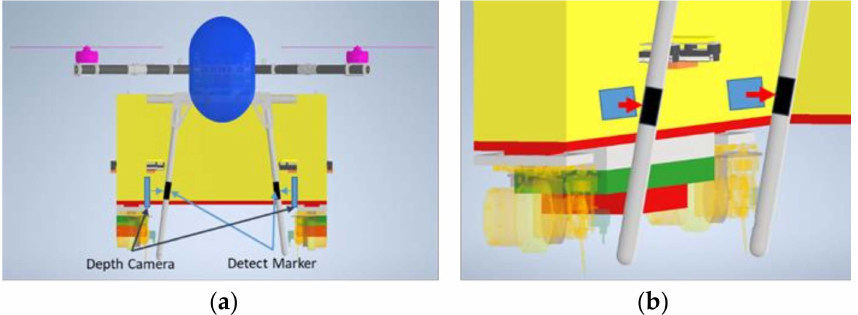
Figure 6. Camera position of the mobile station and the AEV marker’s position. ( a ) the position of the marker and camera as viewed from the front, ( b ) the position of the marker and camera from the inside.